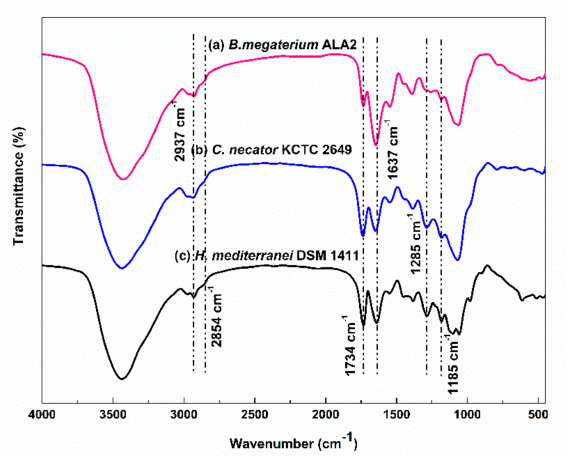
Figure 4. The FTIR spectra of PHA produced by ( a ) Bacillus megaterium ALA2, ( b ) Cupriavidus necator KCTC 2649, and ( c ) Haloferax mediterranei DSM 1411 using 0.3 N HCl DCB hydrolysate as the carbon